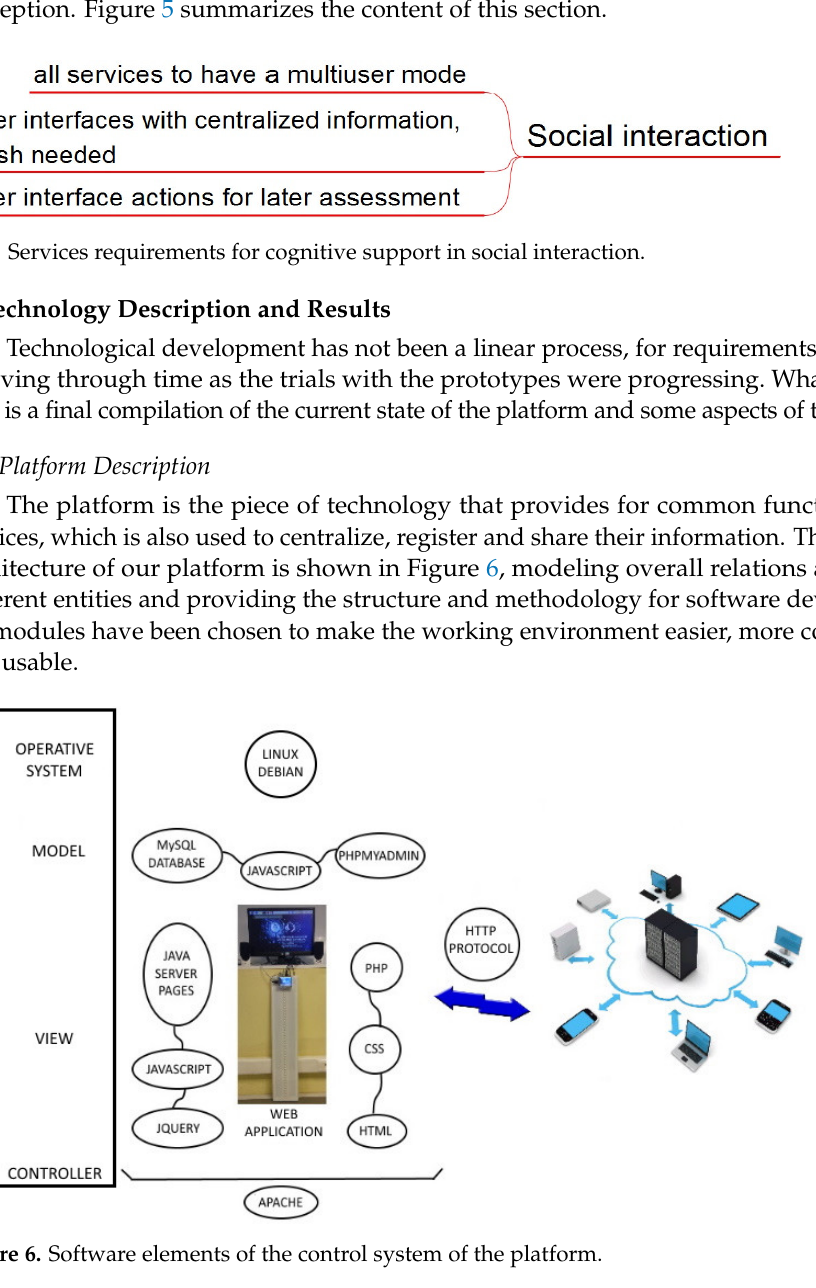
Figure 6. Software elements of the control system of the platform.